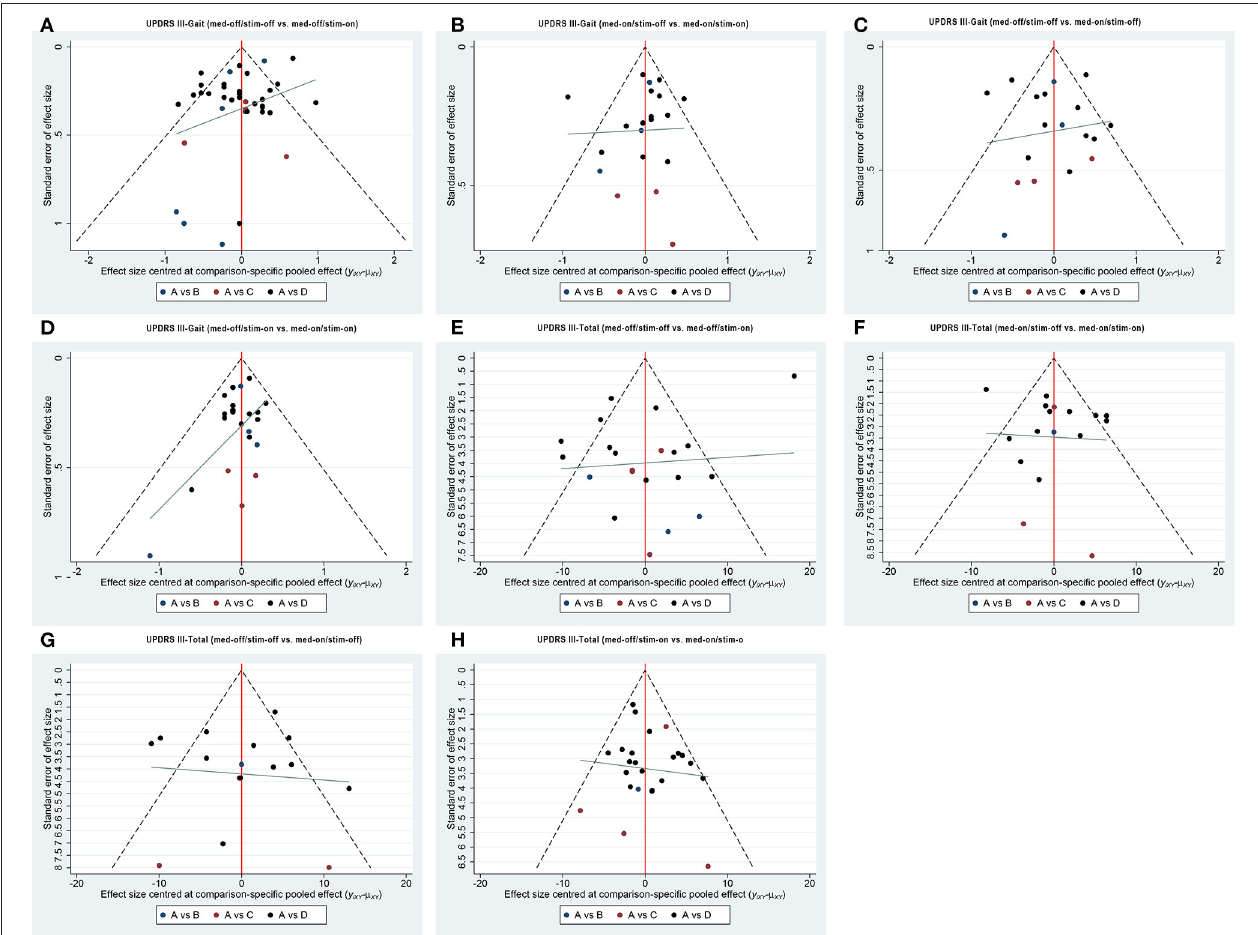
FIGURE 3 | Comparison-adjusted funnel plot for the network of functional outcome; (A) UPDRS III-Gait (med-off/stim-off vs. med-off/stim-on), (B) UPDRS III-Gait (med-on/stim-off vs.med-on/stim-on), (C) UPDRS III-Gait (med-off/stim-off vs. med-on/stim-off), (D) UPDRS III-Gait (med-off/stim-on vs. med-on/stim-on). (E) UPDRS III-Total (med-off/stim-off vs. med-off/stim-on), (F) UPDRS III- Total (med-on/stim-off vs.med-on/stim-on), (G) UPDRS III- Total (med-off/stim-off vs. med-on/stim-off), (H) UPDRS III- Total (med-off/stim-on vs.